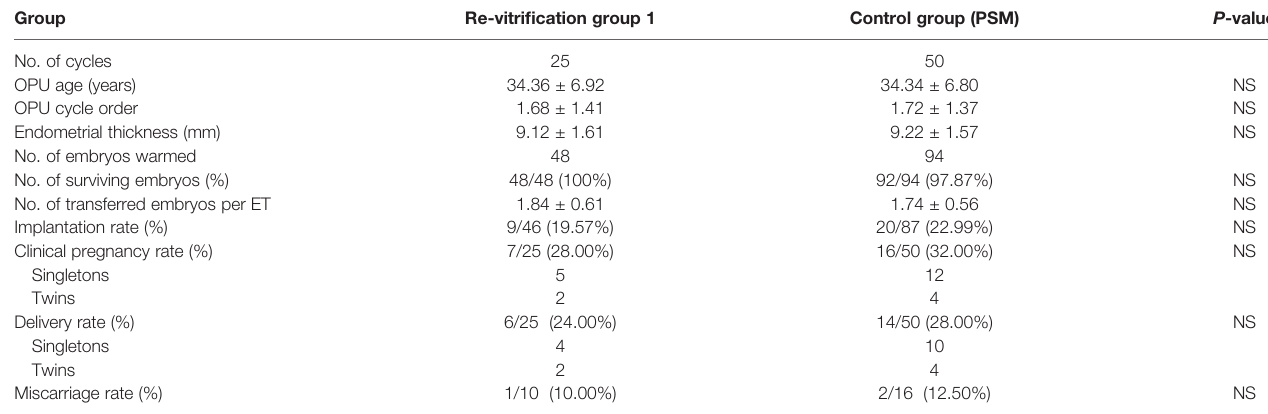
TABLE 1 | Clinical parameters and outcomes of day 3 embryo transfers with once- or twice-vitri fi ed-warmed embryos.